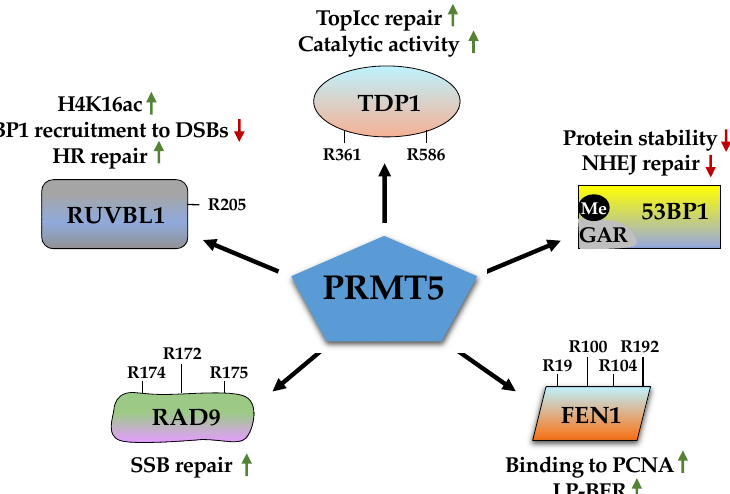
Figure 4. PRMT5 regulates different DNA repair pathways by methylating various DDR proteins, including 53BP1, FEN1, RAD9, RUVBL1, and TDP1. 53BP1, p53-binding protein 1; FEN1, Flap endonuclease 1; RUVBL1, RuvB-like 1; TDP1, Tyrosyl-DNA phosphodiesterase 1; TopIcc, Top I cleavage complexes. Green arrows represent “increase and red arrows represent “decrease”.